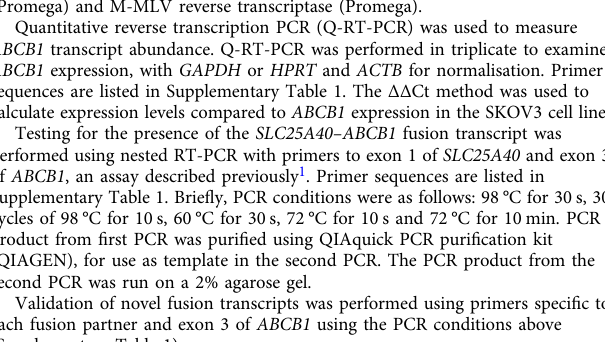
Supplementary Table 1. Brie fl y, PCR conditions were as follows: 98 °C for 30 s, 30 cycles of 98 °C for 10s, 60 °C for 30s, 72 °C for 10 s and 72°C for 10 min.